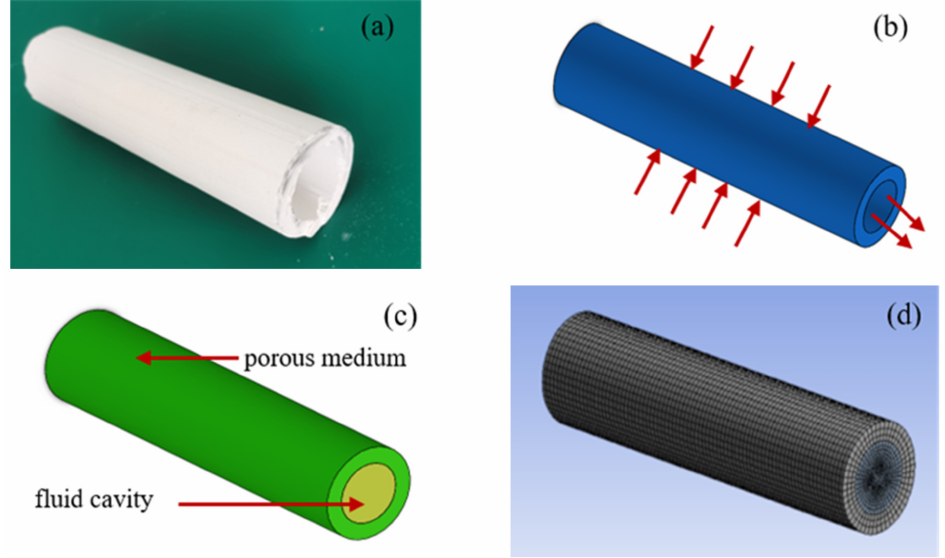
Figure 2. Sample and model of PCMT, ( a ) sample; ( b ) geometric model; ( c ) fluid domain model; ( d )